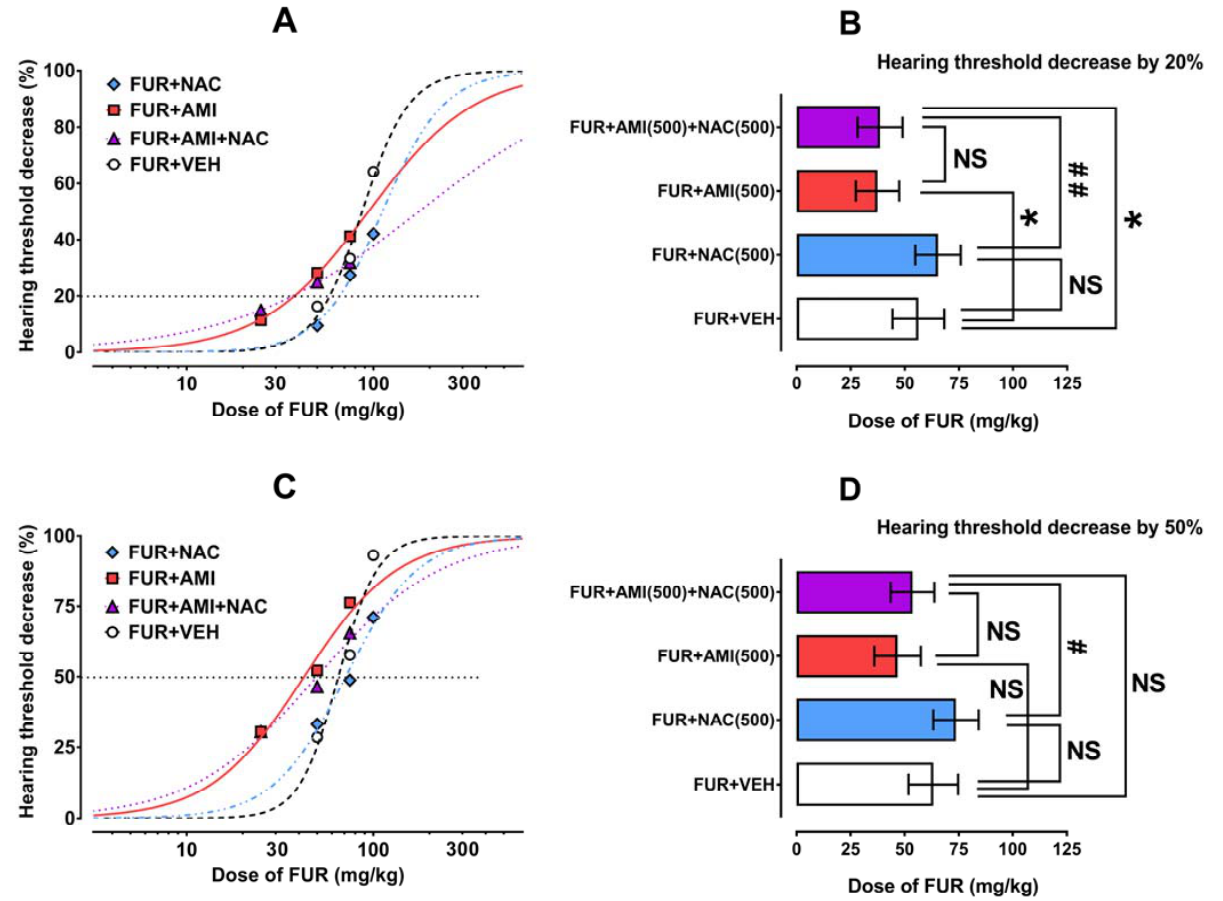
Figure 2. Effects of NAC, AMI and their combinations on FUR-induced hearing threshold decrease in mice. Dose–response relationship curves for FUR-induced hearing threshold decrease of 20% ( A ) and 50% ( C ) are plotted graphically, from which the HTDD 20 and HTDD 50 values (for FUR administered alone and in combination with AMI, NAC, and both compounds) were calculated. The HTDD 20 ( B ) and HTDD 50 ( D ) values were statistically analyzed with one-way ANOVA followed by Holm–Sidak’s multiple comparison tests. * p < 0.05 vs. FUR+VEH-treated animals; # p < 0.05 and ## p < 0.01 vs. FUR+NAC-treated animals. NAC—N-acetylcysteine; AMI—amikacin; FUR—furosemide; NS—nonsignificant; Table 2. Influence of FUR, AMI and NAC on the reduction in hearing threshold in animals re- ceiving the drugs either alone or in combination.